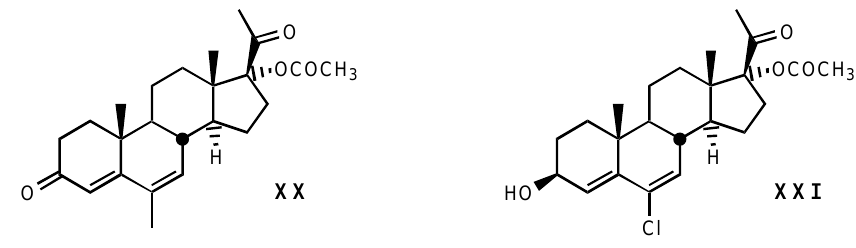
Figure 20. Structure of megestrol acetate ( XX ) and chlormadinol acetate (CMA, XXI